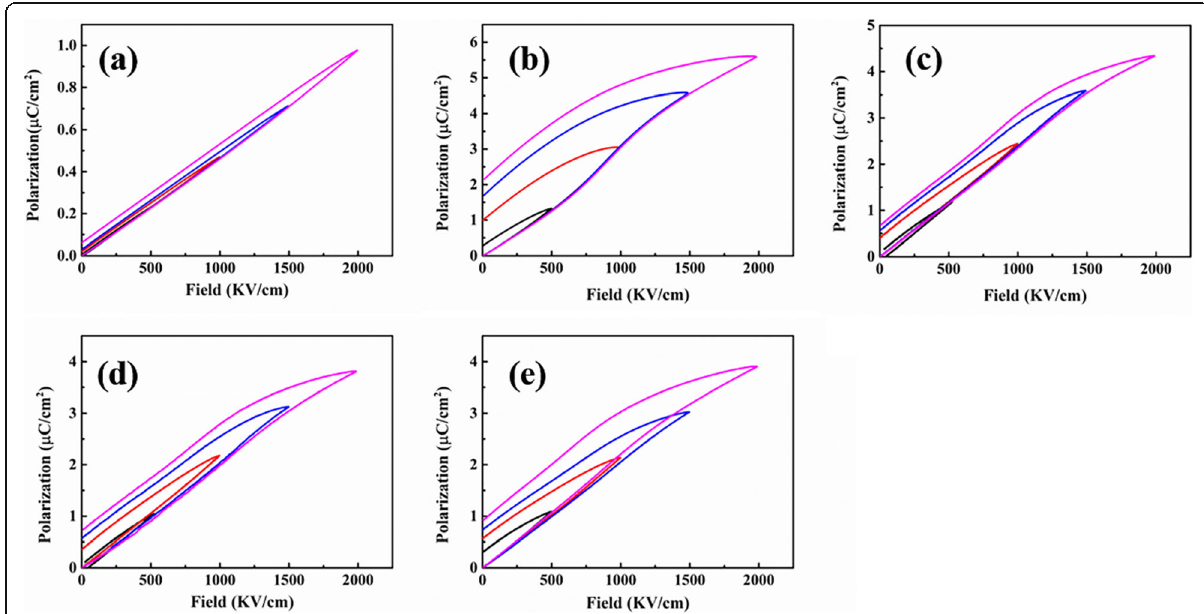
Fig. 8 Unipolar polarization-electric field hysteresis loops. a ArPTU. b PVDF-TrFE-CFE. c PVDF-TrFE-CFE/ArPTU (95/5). d PVDF-TrFE-CFE/ArPTU (90/ 10). e PVDF-TrFE-CFE/ArPTU (85/15)